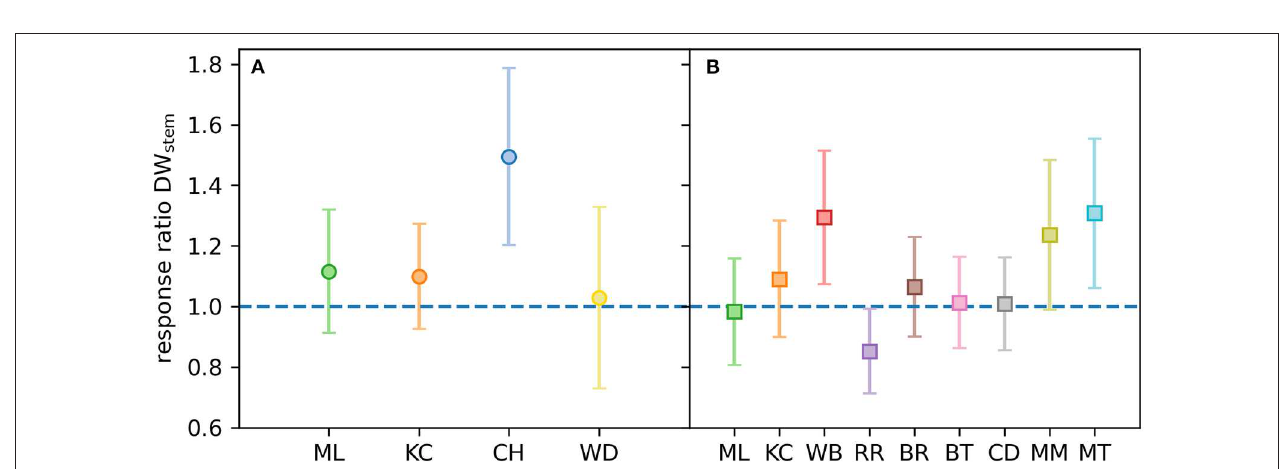
FIGURE 7 | Response ratios of stem dry weight at harvest (DW stem ) for Experiment 1 and 2. Response ratios represent differences in the different provenances of E. grandis grown under elevated [CO 2 ] (B) compared to ambient [CO 2 ] ( A ; n = 3–7 per provenance and [CO 2 ] treatment). Colors in (A) represent the four selected provenances of Experiment 1 and colors in (B) represent the nine selected provenances of Experiment 2. Error bars represent variance.